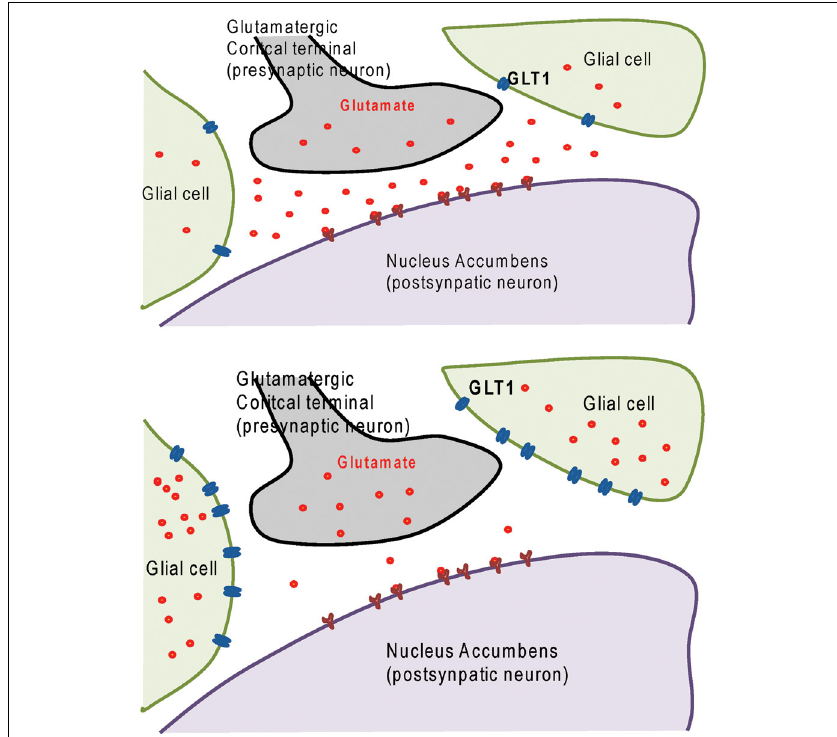
FIGURE 1 | Upper panel: diagram shows glutamatergic cortical terminal in contact with postsynaptic neuron in nucleus accumbens surrounded by glial cells expressing glutamate transporter 1 (GLT1). Lower panel: diagram shows increased of GLT1 level in glial cells and decreased synaptic glutamate concentration as a consequence of treatment with GLT1 upregulator such as ceftriaxone and